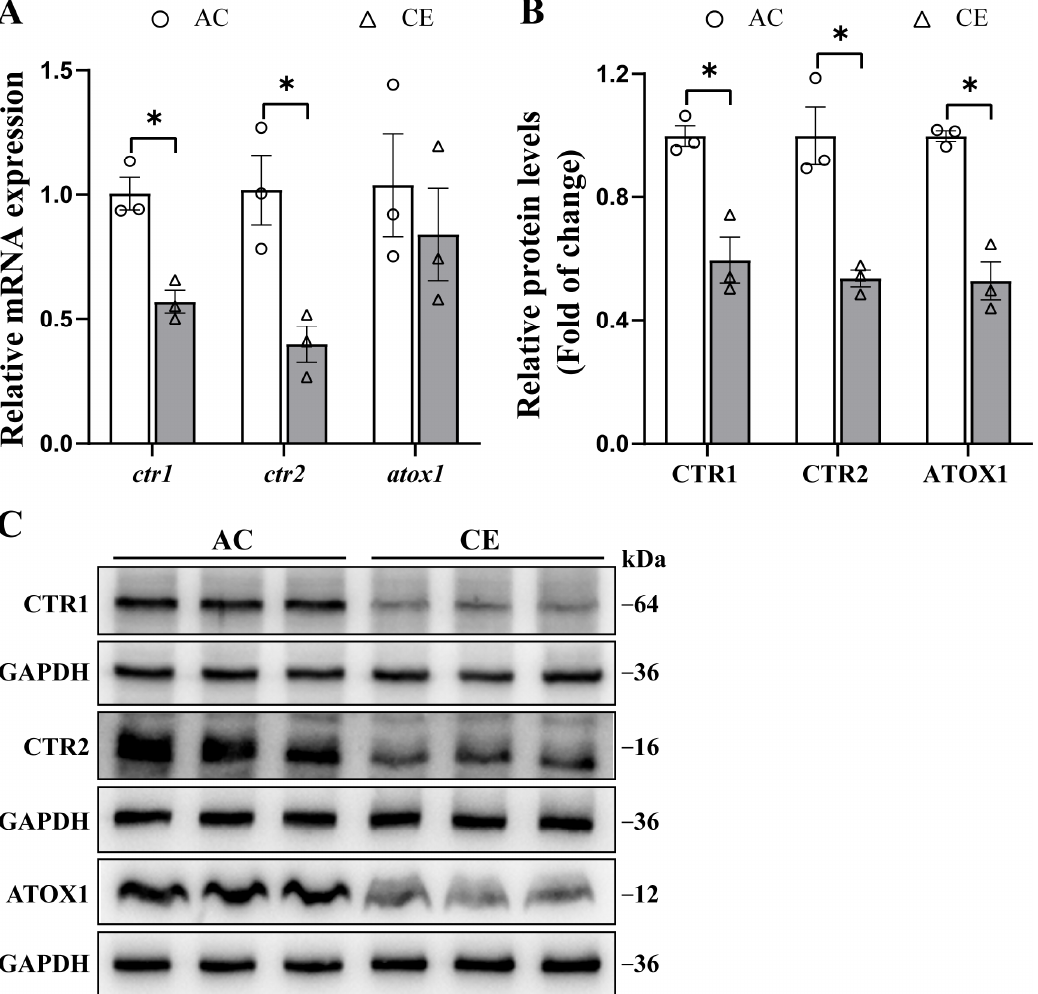
Figure 5. Effects of dietary Cu levels on ctr1 , ctr2 and atox1 expression in the liver tissues of yellow catfish. ( A ) ctr1 , ctr2 and atox1 gene expressions normalized to tbp and rpl7 ; ( B ) the relative densities of total CTR1, CTR2 and ATOX1 protein were measured by Image-Pro Plus; ( C ) CTR1, CTR2 and ATOX1 total protein expression. Values are means ± SEM ( n = 3), and experiments were repeated three times. p value was calculated by one-way ANOVA and further post hoc Duncan’s multiple range testing. Asterisk (*) indicates significant differences between the two treatments ( p < 0.05).